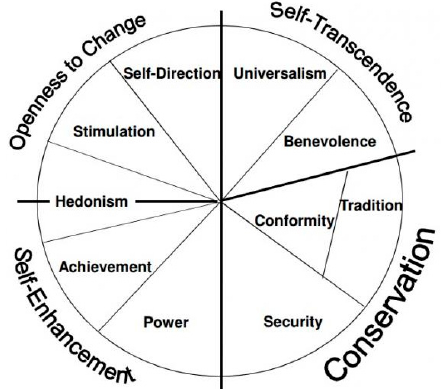
Figure 1. Schwartz motivational values. From Schwartz (2012) .